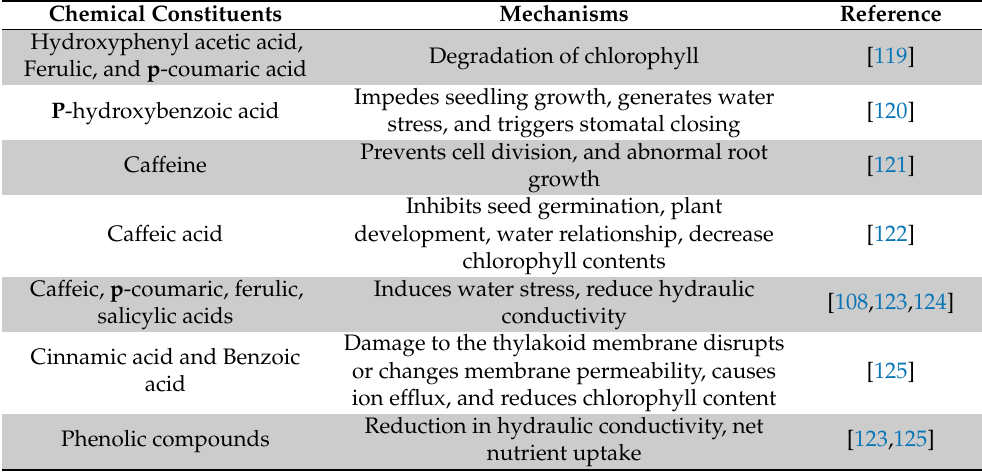
Table 2. Different chemical constituents of Parthenium hysterophorus